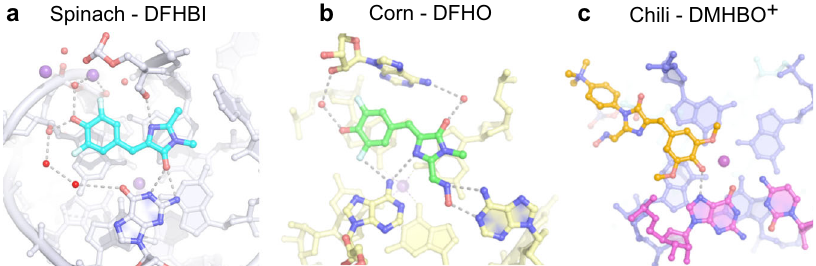
Fig. 6 Comparison of RNA binding sites for HBI analogs in fl uorogenic aptamers. a Spinach – DFHBI (pdb 4TS0). b Corn – DFHO (pdb 5BJO). c Chili – DMHBO + (pdb 7OAX). The ligand is shown on top of the nearest G-quartet and H-bonding interactions to the phenol/phenolate, imidazolone and oxime are